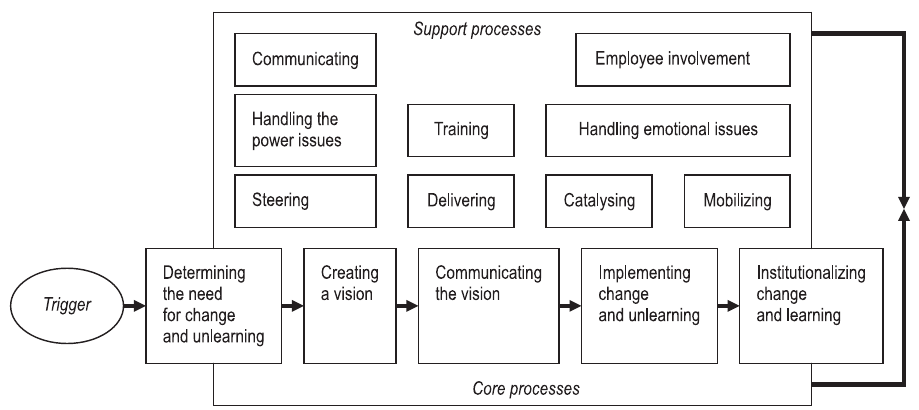
Fig. 1. The process model for the implementation of organizational